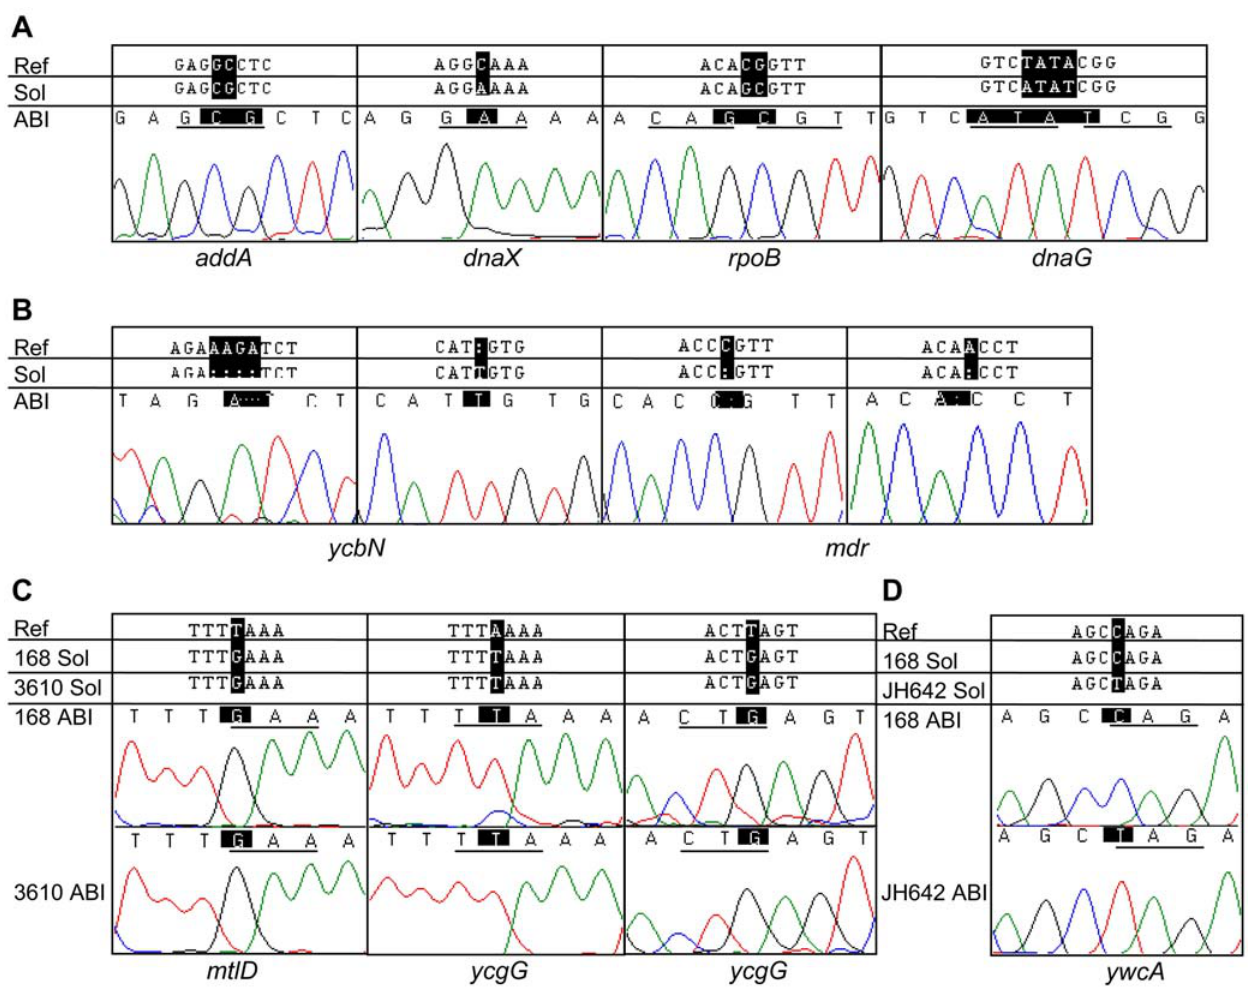
Figure 3. Verification of the Solexa results by Sanger sequencing. A) Selected reads from strain 168 where results from Solexa suggest missense changes with respect to the reference. B) Selected reads from strain 168 where results from Solexa suggest insertions or deletions with respect to the reference. C) Selected reads from 168 and NCIB 3610 where results from Solexa suggest nonsense mutations in the reference sequence. D) Selected reads from JH642 and 168 where results from Solexa suggest nonsense changes in JH642 with respect to 168. In each case, the published reference sequence is indicated first, the Solexa sequence(s) are shown next, and the Sanger sequencing results and corresponding chromatograms are depicted last.